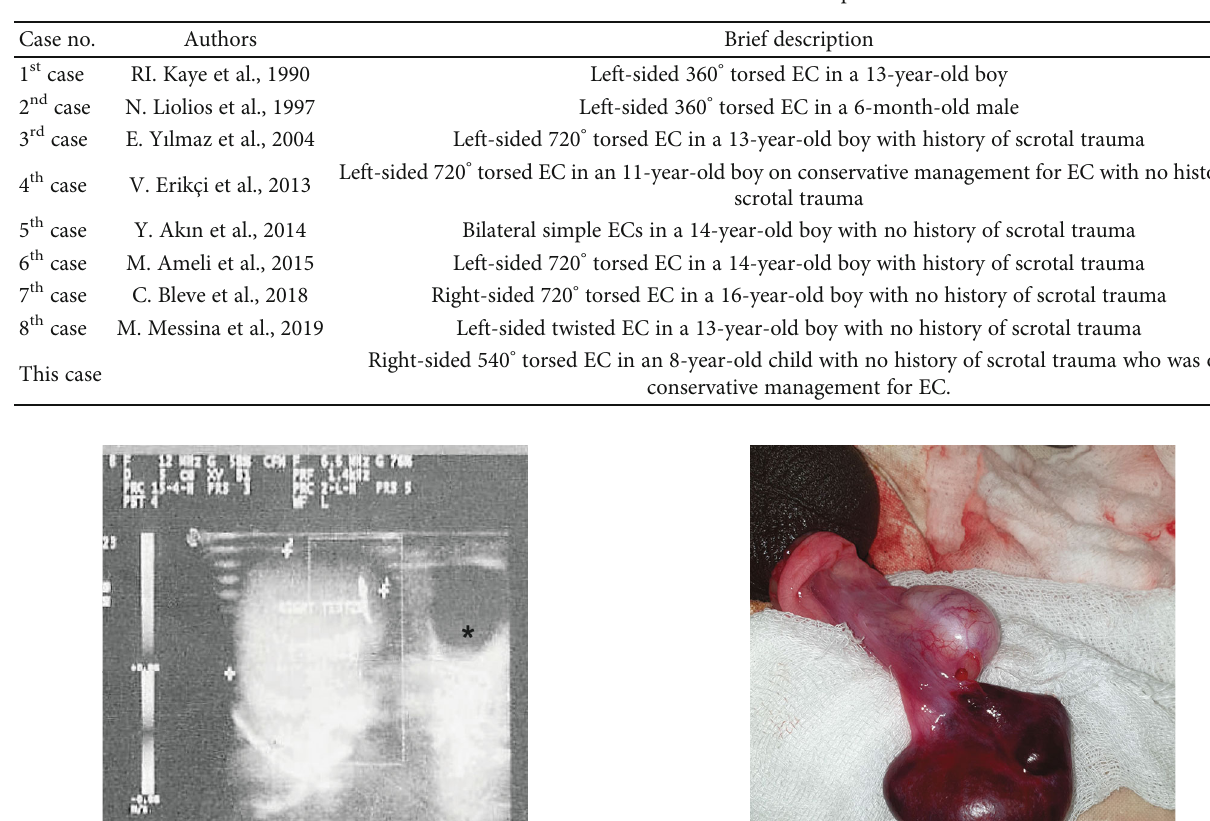
Table 1: List of cases in literature with brief description.